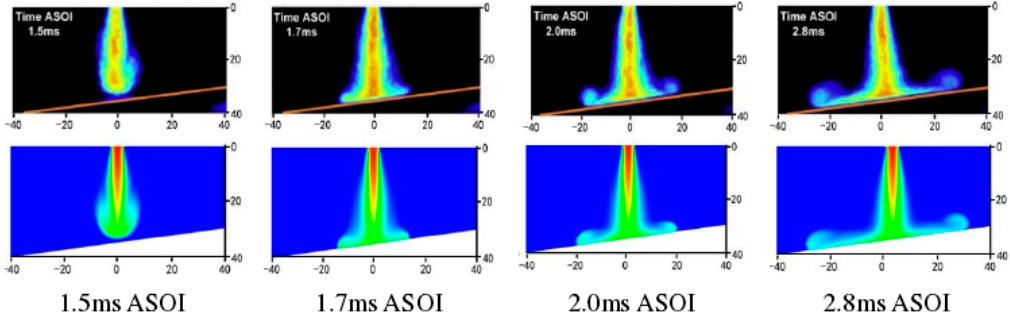
ff erent moments.